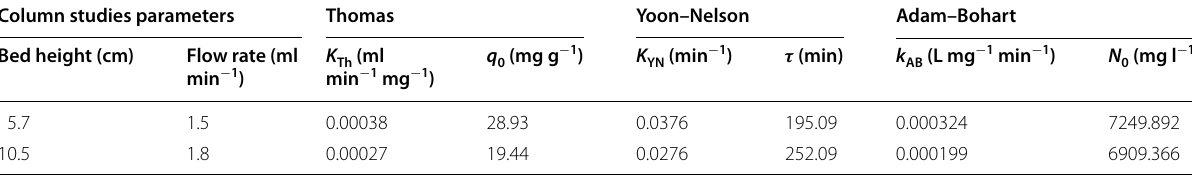
Table 7 Values of parameters obtained from Thomas model, Yoon–Nelson model and Adam–Bohart model Column studies